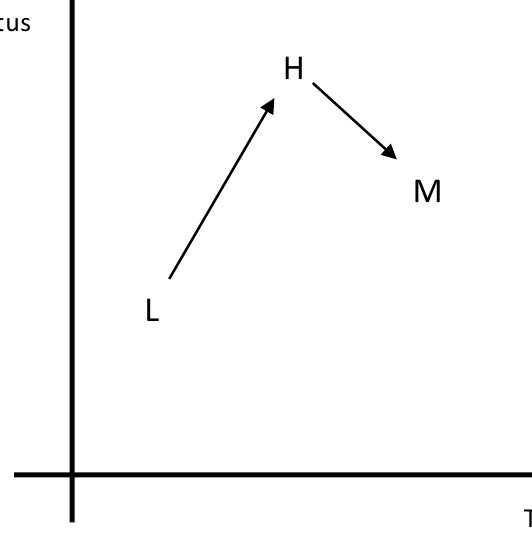
Fig. 4b. Low Status Provenance Diffusion Pattern